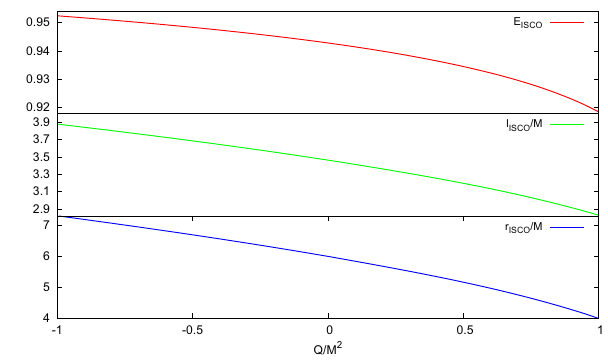
Fig. 3 E ISCO , l ISCO and r ISCO of the timelike particle around the DMPR brane-world black holes against Q for ISCO